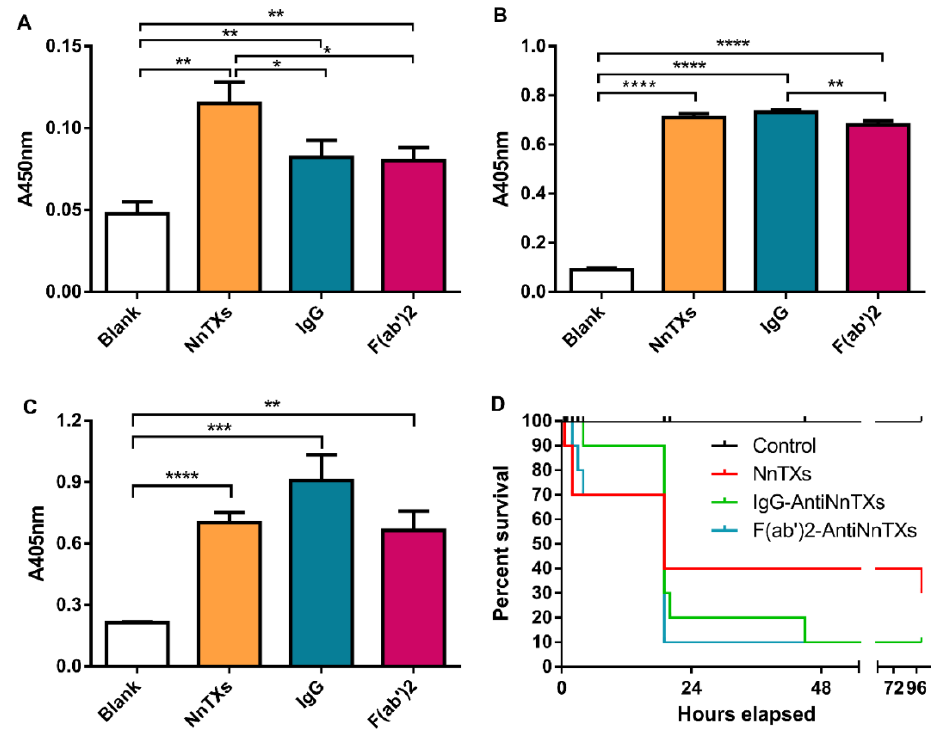
Figure 6. Neutralization assay of antivenoms against the toxicities of NnTXs. ( A ) Neutralization assay of antivenoms against the metalloprotease activity of NnTXs in vitro, ( B ) neutralization assay of antivenoms against the hemolytic activity of NnTXs in vitro, and ( C ) Neutralization assay of antivenoms against the PLA 2 activity of NnTXs in vitro. * p < 0.05; ** p < 0.03; *** p < 0.0003; **** p < 0.0001; n = 3. ( D ) Neutralization assay of IgG-AntiNnTXs and F(ab’) 2 -AntiNnTXs against the lethality of NnTXs in vivo ( n = 10). Control: injection of dialysis buffer; NnTXs: injection of NnTXs; IgG: injection of IgG-AntiNnTXs neutralized NnTXs; F(ab’) 2 : injection of F(ab’) 2 -AntiNnTXs neutralized NnTXs.